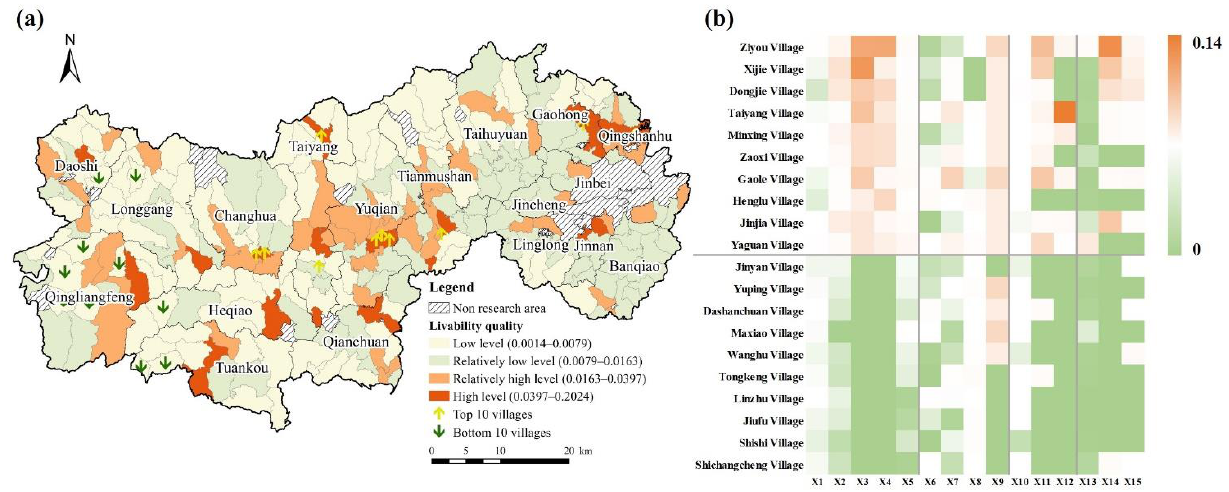
Figure 5. Performance of livability quality in Lin’an District. ( a ) Livability conditions index. ( b ) Top 10 villages and bottom 10 villages. The top 10 villages are above the horizontal line; the bottom 10 villages are below the horizontal line; X1 – X5 represent livability condition indicators; X6 – X9 represent employment context indicators; X10 – X12 represent consumption level indicators; and X13 – X15 represent leisure culture indicators.